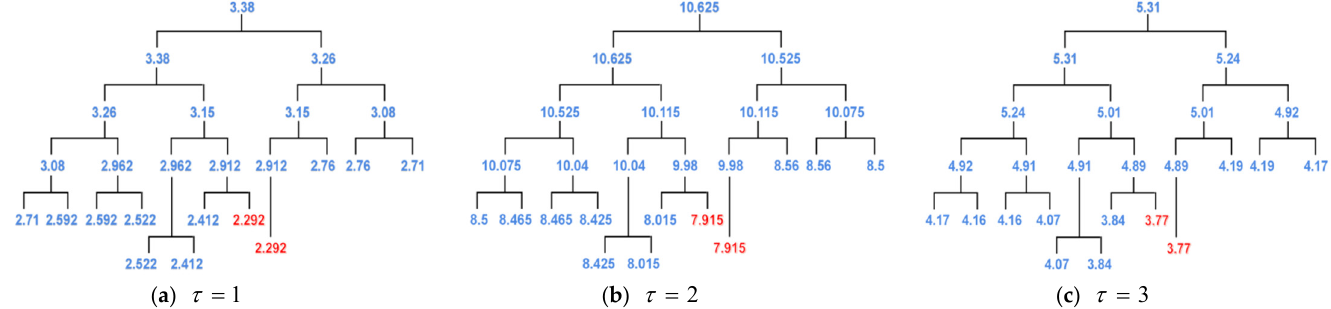
Figure 14. The maximum complete binary tree based on the global weight iteration value G ( Z o ( R maximum heap result in different transportation modes.